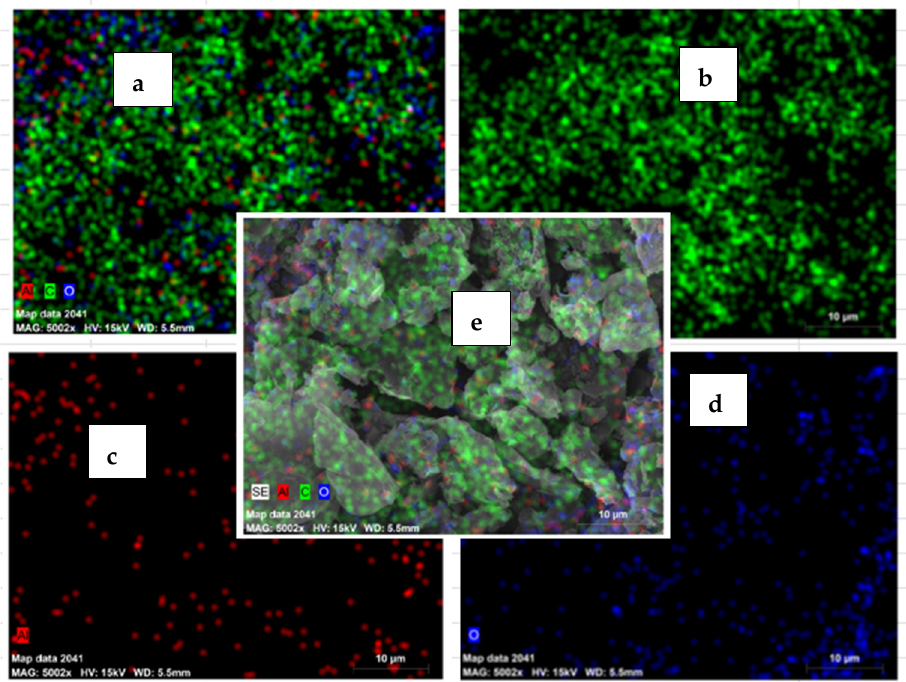
Figure 12. XRD for PEO coatings generated from the experimental configuration of 197 V and 20 mm, 35 mm, 40 mm electrode distances.